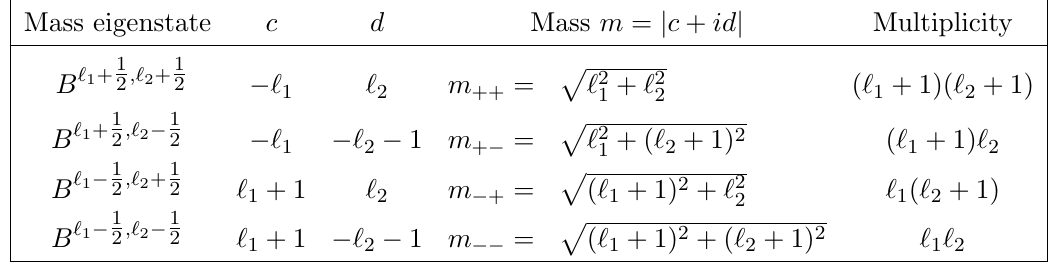
Table 4 . Eigenvalues and eigenstates of the fermions in the SO(3) (cid:2) SO(3)-symmetric case in the k 1 k 2 (cid:2) k 1 k 2 block. One must consider all combinations of ‘ 1 = 0 ; : : : ; k 1 (cid:0) 1 and ‘ 2 = 0 ; : : : ; k 2 (cid:0) 1. For the de(cid:12)nition of c and d , see (2.70). The values for c , d and m for the (cid:12)elds in the o(cid:11)-diagonal